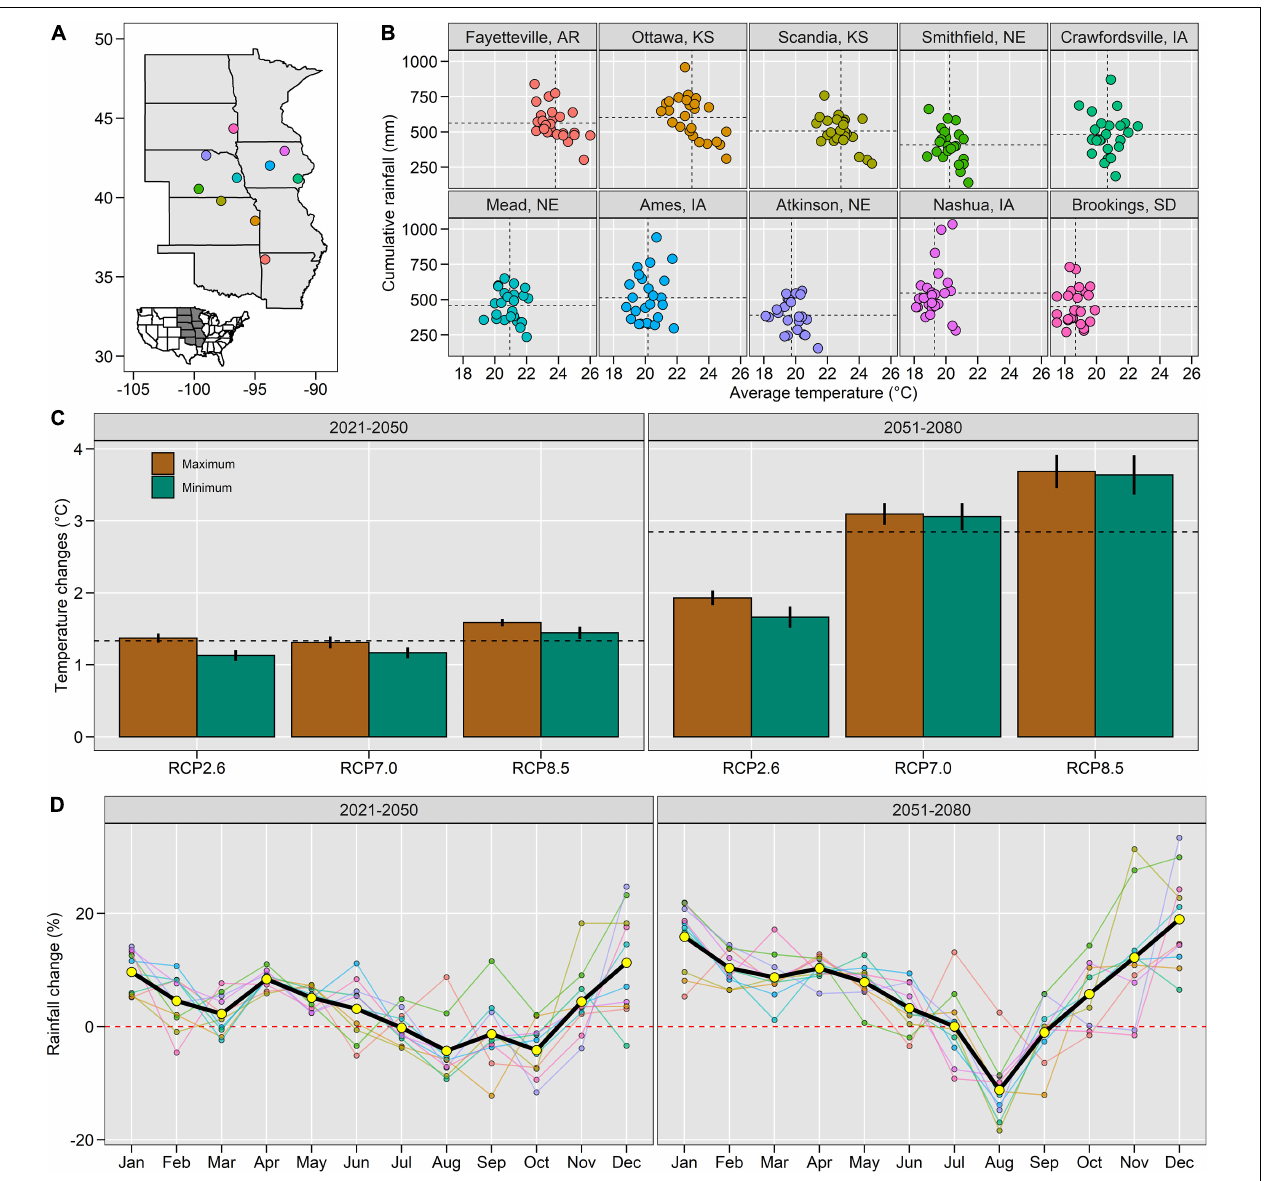
FIGURE 1 | Spatial distribution of experimental locations (A) , year-to-year (1995–2020) variability of average temperatures and cumulative rainfall from May to September (horizontal and vertical dashed lines indicate the average values) (B) , average temperature changes in relation to the baseline for 2021–2050 and 2051–2080 under RCP2.6, RCP7.0, and RCP8.5 (vertical bars represent the standard deviation from the 10 locations and horizontal dashed lines represent the average change) (C) , monthly rainfall changes in relation to the baseline (black lines indicate averages from five global circulation models, three RPCs and 10 locations, while colored lines represent the variability across the 10 locations) (D)